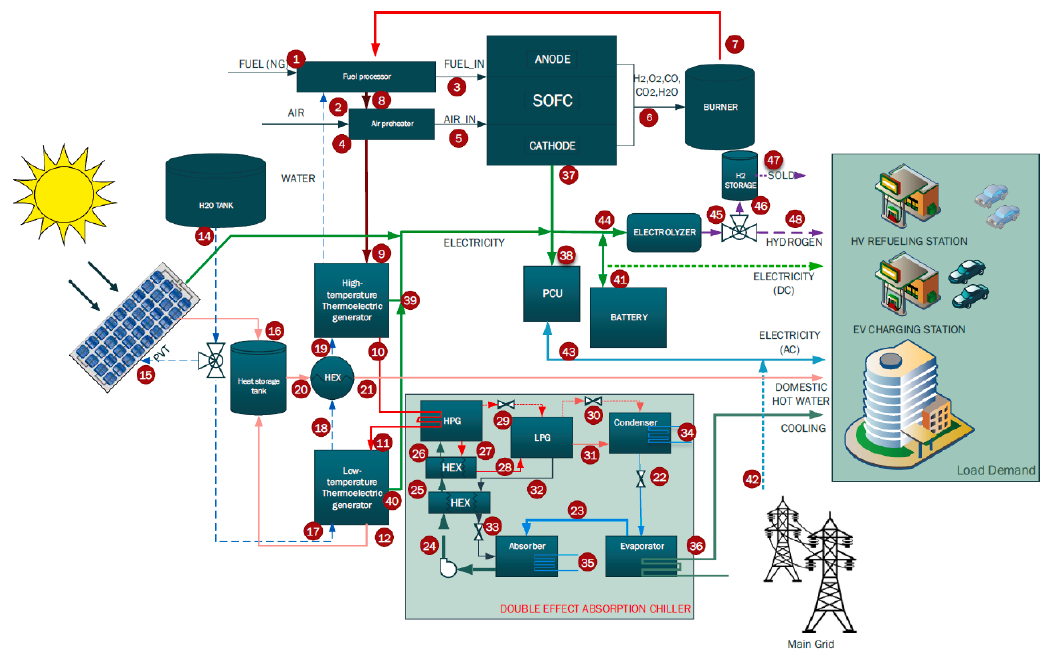
Figure 4. A polygeneration system with integrating SOFCs and renewable energy for residential use [2,4]. PCU: power conditioning unit, H 2 O: water, H 2 : hydrogen, HEX: heat exchanger, LPG: low pressure gradient (pump), HPG: high pressure gradient (pump), EV: electric vehicle, HV: hydrogen vehicle.